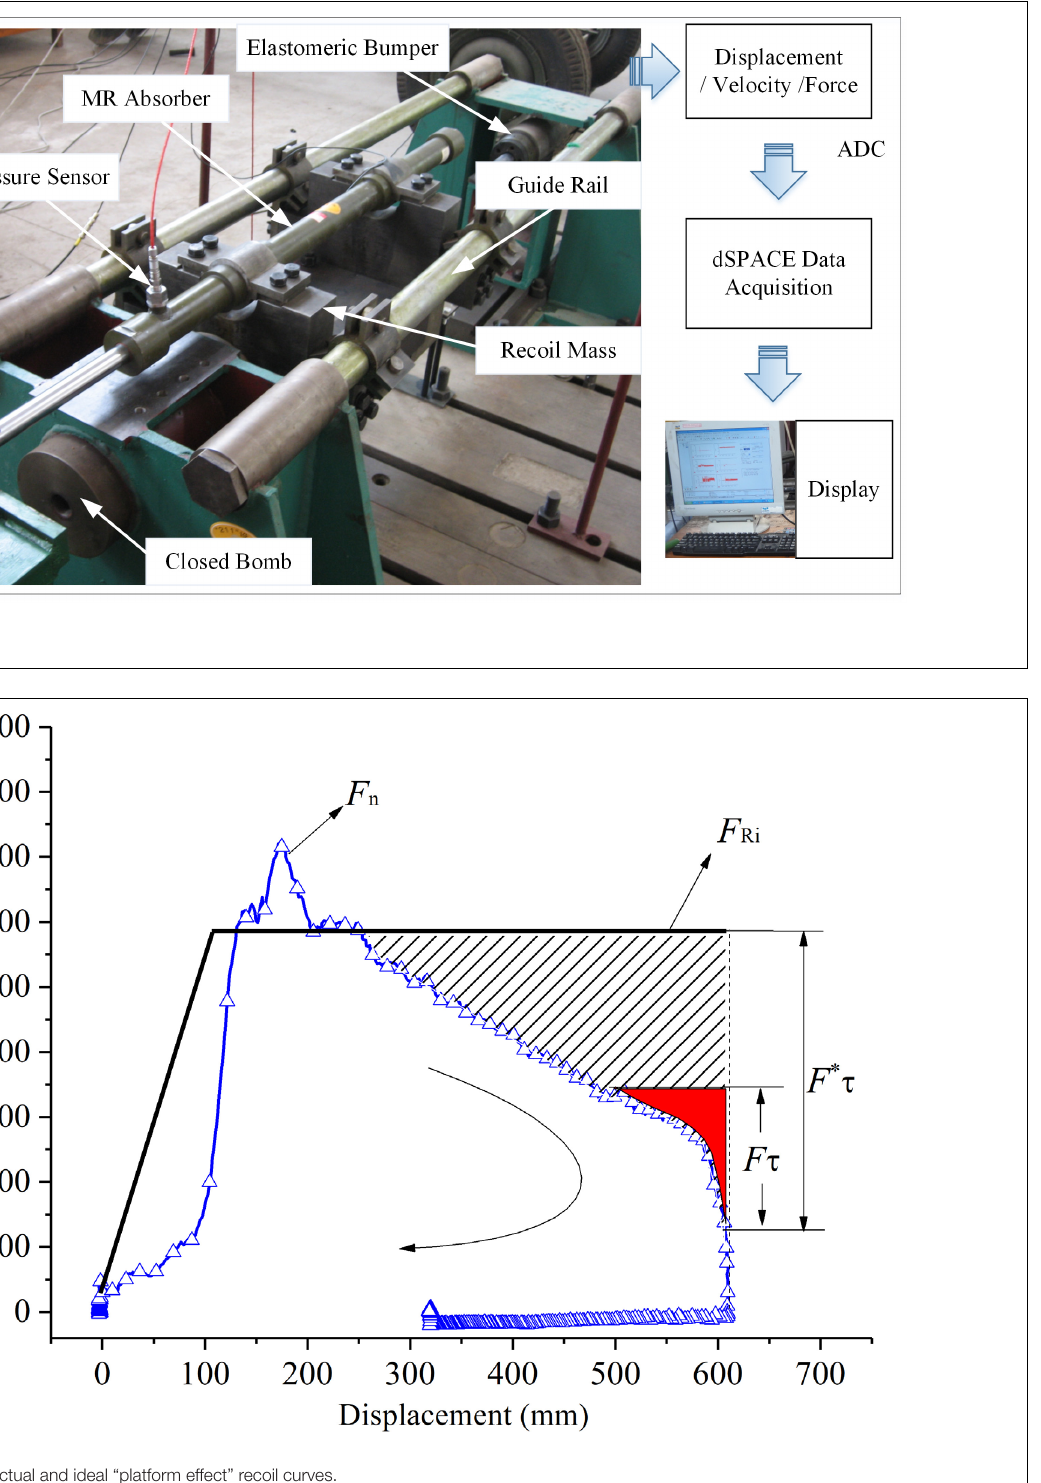
cannot completely consume the recoil impact energy without rebound in a given recoil stroke. The constraint conditions in Eq. (9) are not